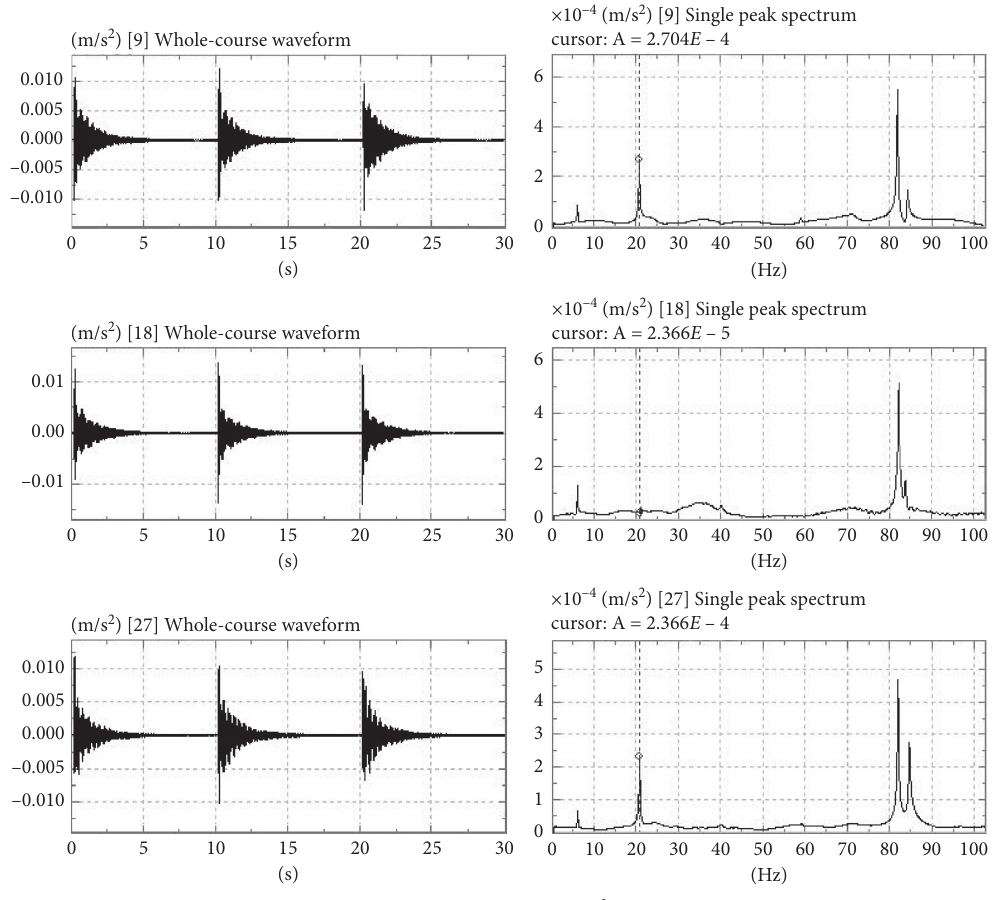
Figure 22: Spectrum curve of case